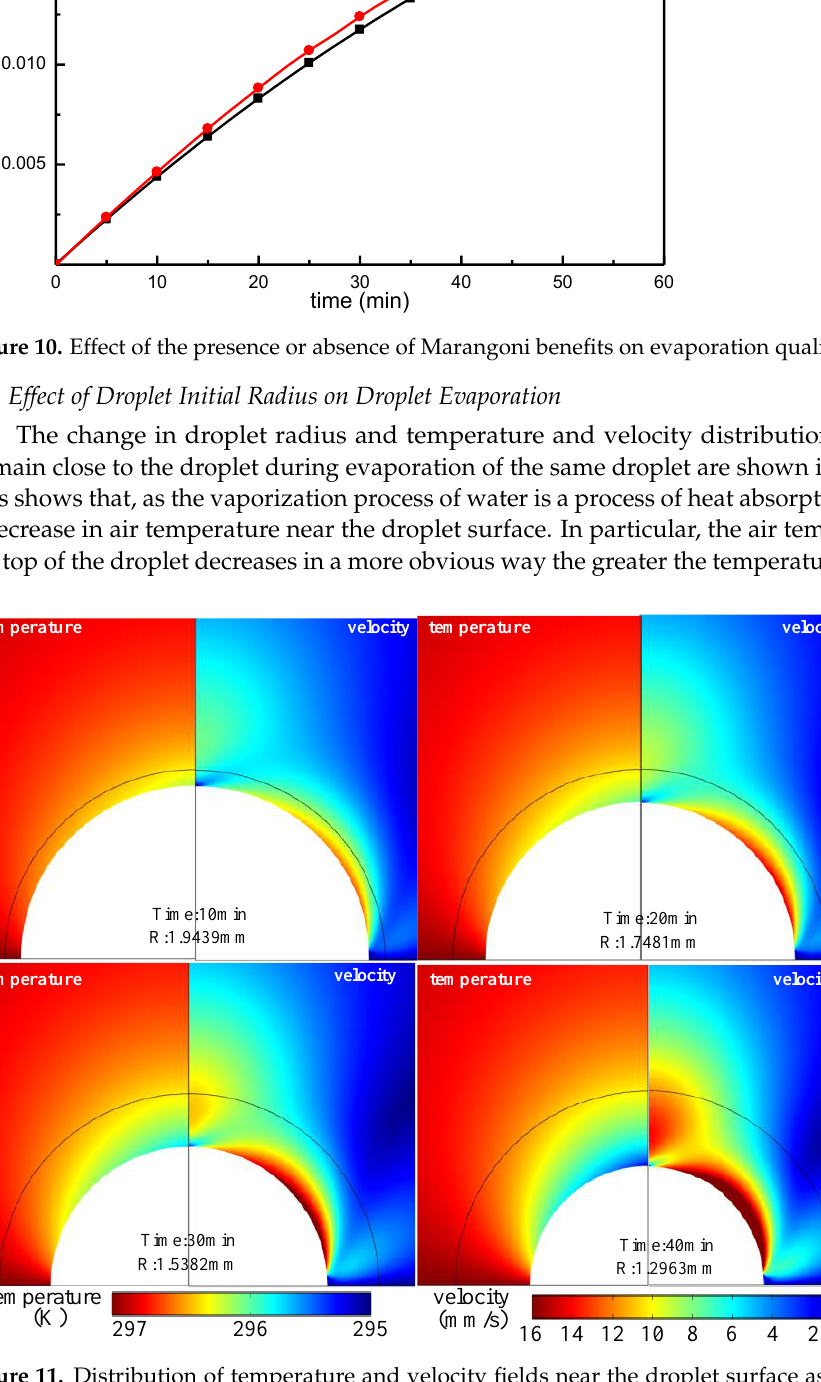
R x o Figure 9. Temperature distribution on the centerline of the droplet. As shown in Figure 5, without the Marangoni effect, convection within the droplet is weak, and the heat transfer is dominated by the heat conduction of the droplet. In order to further compare the contribution of the Marangoni effect to the efficiency of evapora- tion, in order to quantify and compare the two cases, we use the evaporation mass change of the droplet, as can be seen in Figure 10. The results show that, compared to the lack of the Marangoni effect, the effect can be used to improve the efficiency of evaporation, com- bined with the change in temperature and velocity fields between. The longer the duration